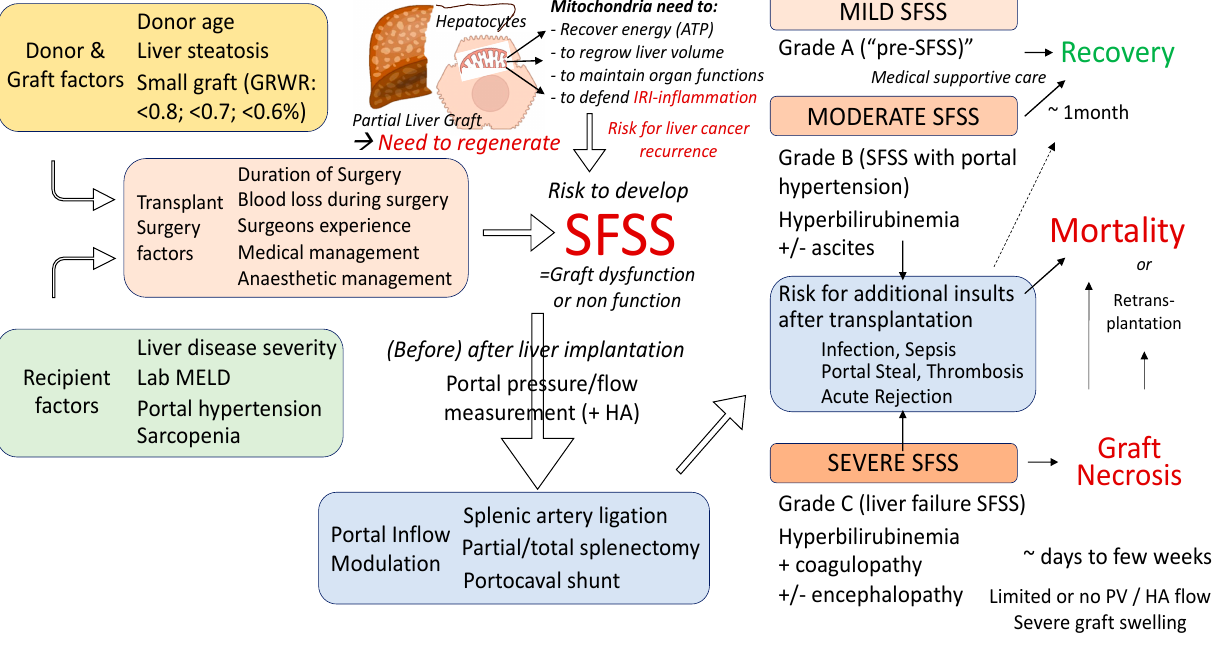
Figure 3. Multiple factors contributing to the development of a small for size syndrome (SFSS) after living donor liver transplantation: Overview on development, risk factors and outcomes of SFSS. In experienced centers, the GRWR can go down to 0.6% and/or GV/SLV ≥ 30% in recipients with low MELD and no signi fi cant portal hypertension, related to liver tissue quality. Disturbed blood fl ows along with elevated levels of IRI lead to an ongoing in fl ammation, creating a microenvironment that promotes the rese tt lement and replication of circulating cancer cells, further pronounced by pro-regenerative molecules released to promote liver repair and regeneration.